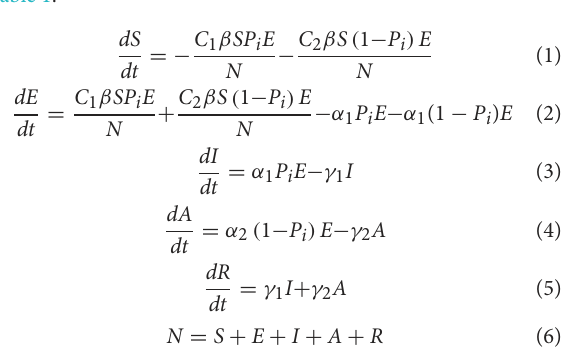
and the parameters of the model are described in